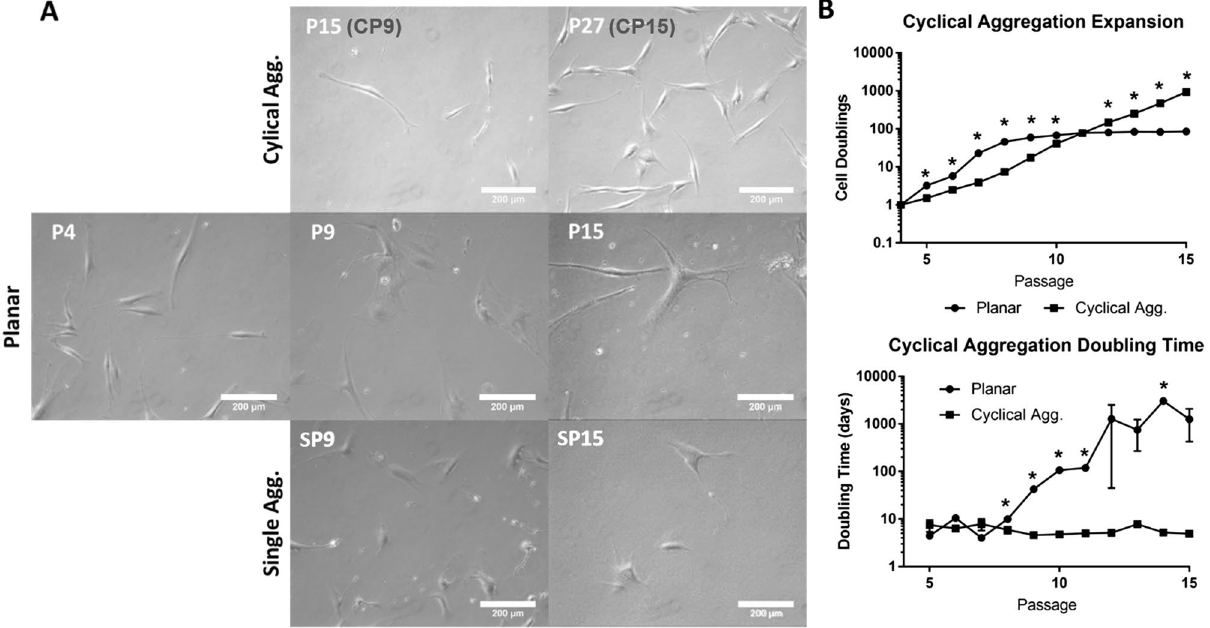
Figure 1. Assessment of ASC morphology along with growth kinetics to determine the effects of cyclical aggregation. ( A ) Morphologic assessment revealed the loss of spindle shape in planar expansion, yet morphology was maintained via cyclical aggregation. ( B ) Analysis of ASC doublings and doubling time revealed that while planar cells were able to expand readily during early passages, the cells were eventually outpaced by aggregated cells which also maintained doubling time. Data represents the mean of at least three independent determinations; errors represent the standard error in the mean. * p <